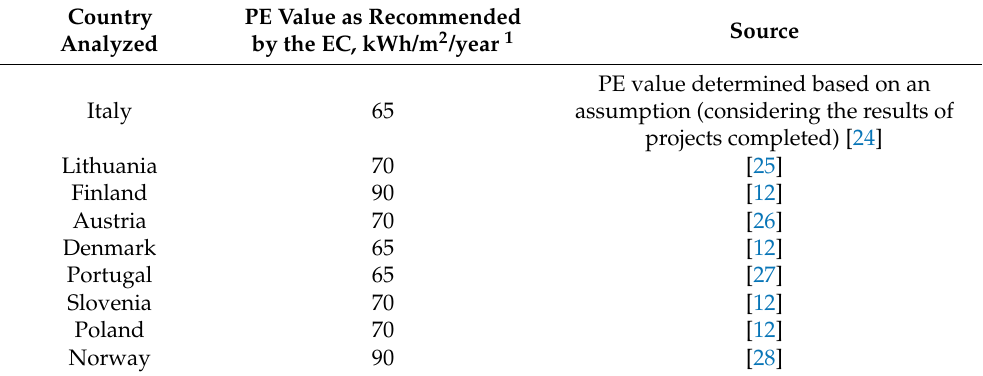
Table 3. PE values in the countries covered by the analysis and those recommended by the European Commission.